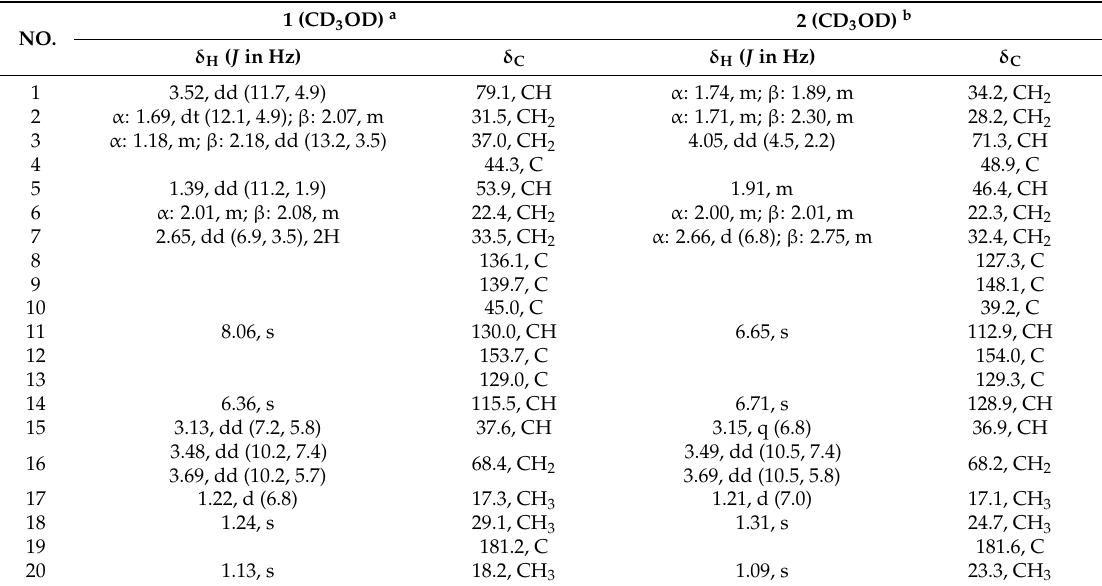
Table 1. 1 H- and 13 C-NMR data ( δ in ppm) for compounds 1 and 2 .